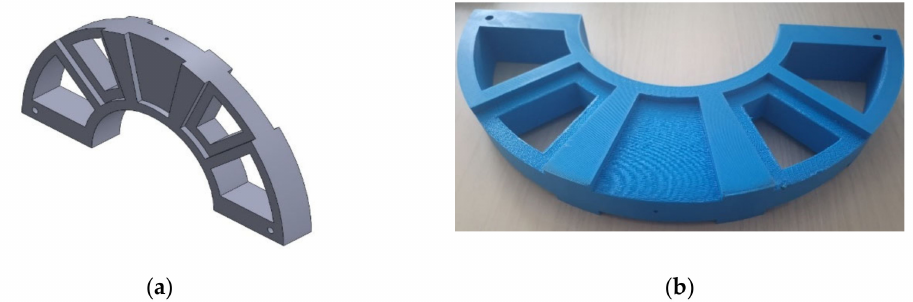
Figure 10. Tool developed for the measurement of the axial component of magnetic flux density: ( a ) 3D model, ( b ) printed tool.